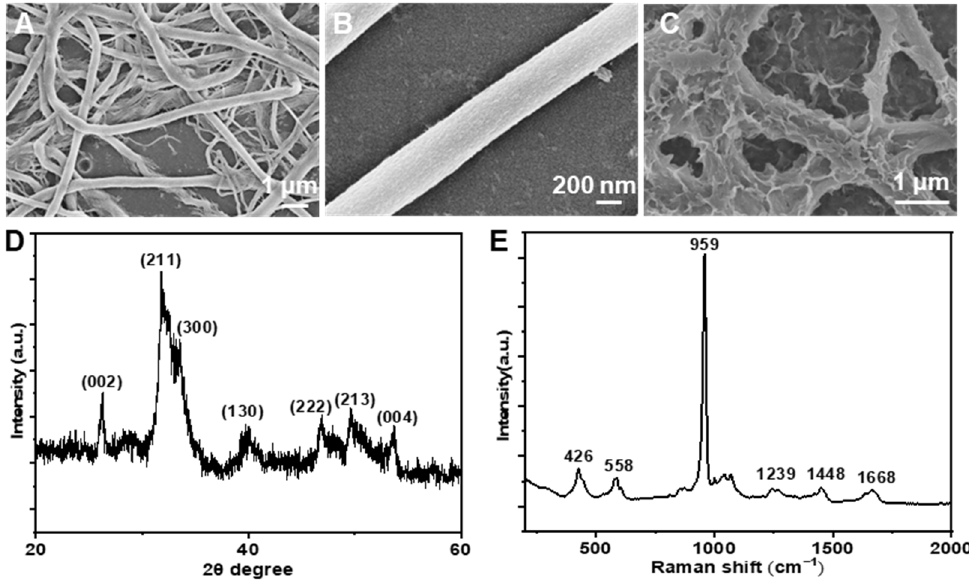
Figure 1. Morphology and composition of the collagen fibrils with intrafibrillar HAP nanocrystals. ( A ) Low magnification SEM image of fibrils. ( B ) High magnification SEM image of a fibril. ( C ) The extrafibrillar HAP on the surface of collagen fibrils. ( D ) XRD of the fibrils. ( E ) Raman spectrum of the fi brils.